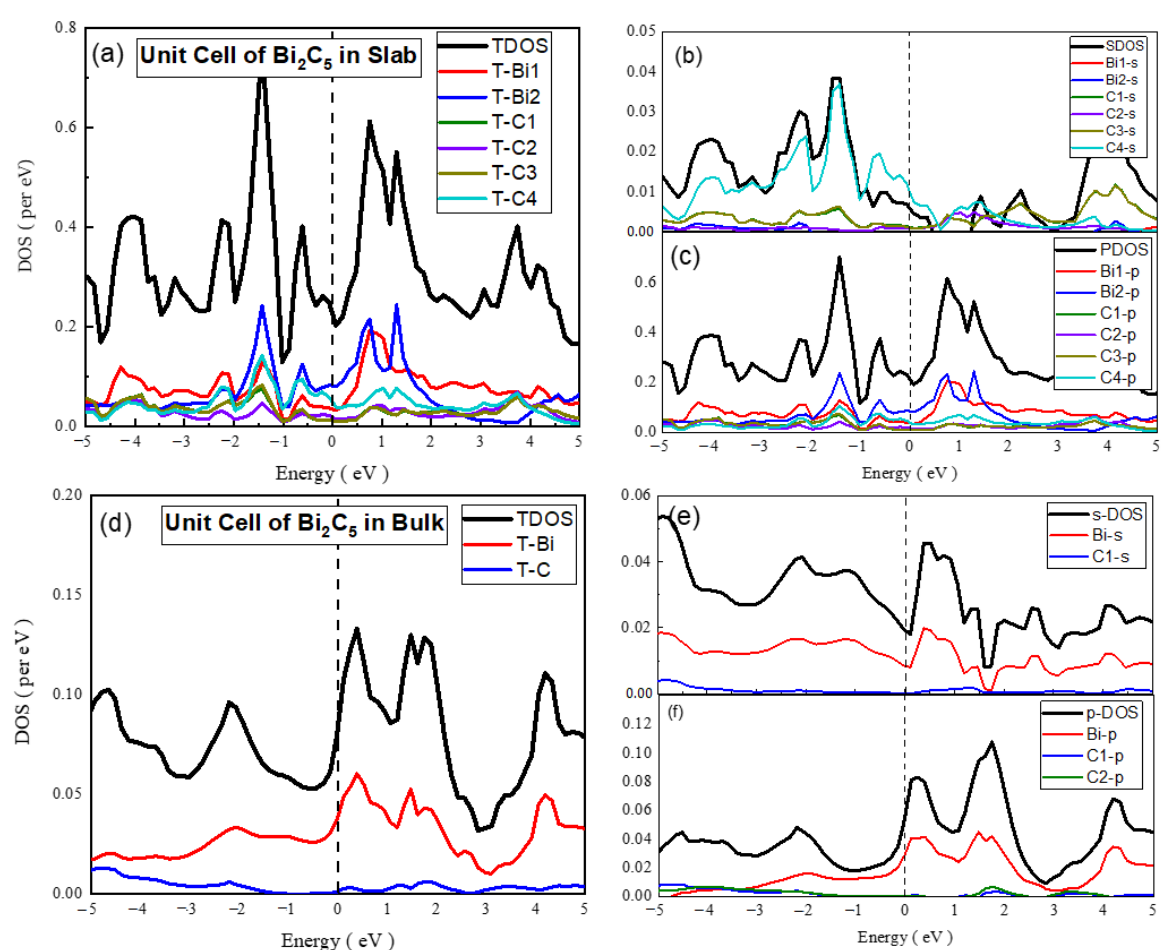
Figure 10. The calculated total density of states (TDOS) and partial density of states for mentioned atoms in Bi 2 C 5 unit cell ( a ) TDOS of slab ( b ) s-DOS of slab ( c ) p-DOS of slab ( d ) TDOS of bulk ( e ) s-DOS of bulk ( f ) p-DOS of bulk. The Fermi level was adjusted at 0 eV.